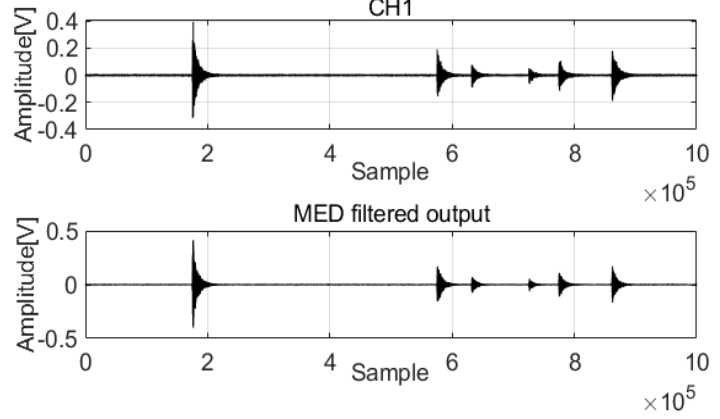
Figure 9. MED method for the acoustic signals in Channel 1.